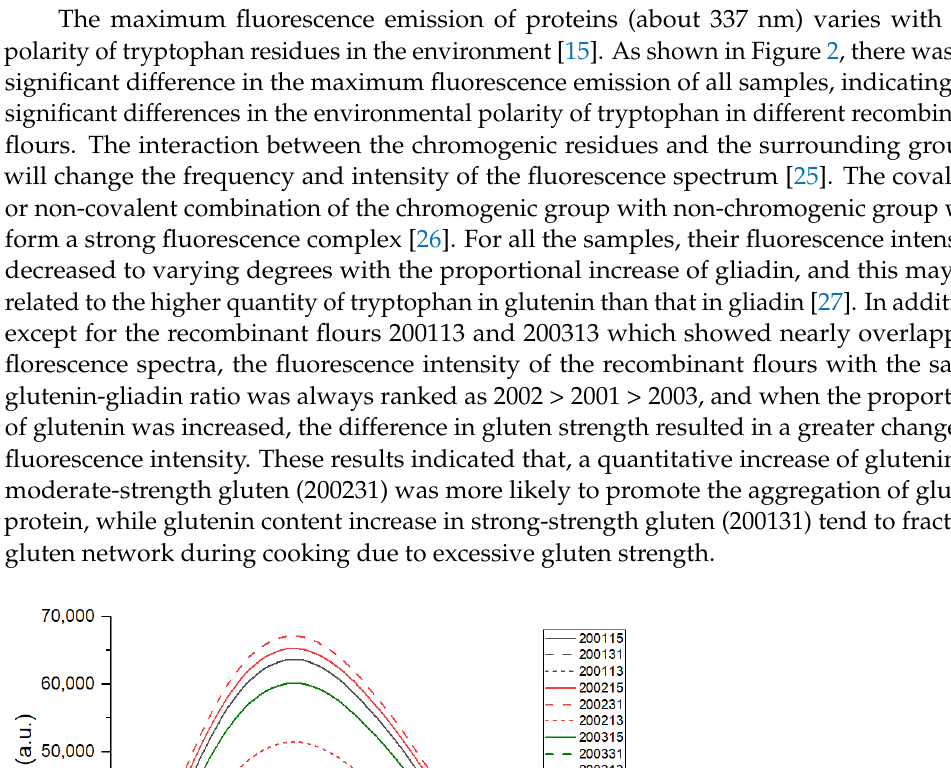
Figure 1. In vitro digestion curve ( A ) and the contents of RDS, SDS, and RS ( B ) in recombinant flours. (Means with different small letters within the same category are significantly different at p < 0.05).